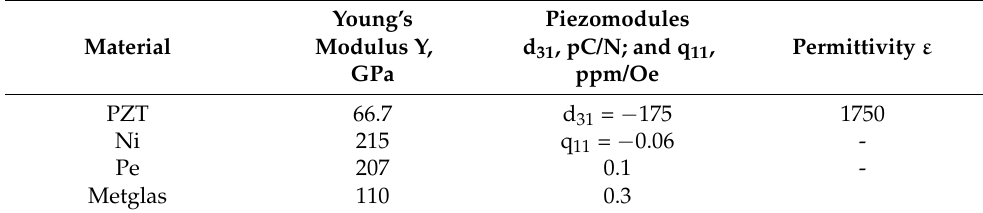
Table 1. Parameters of materials of composite structures [33].